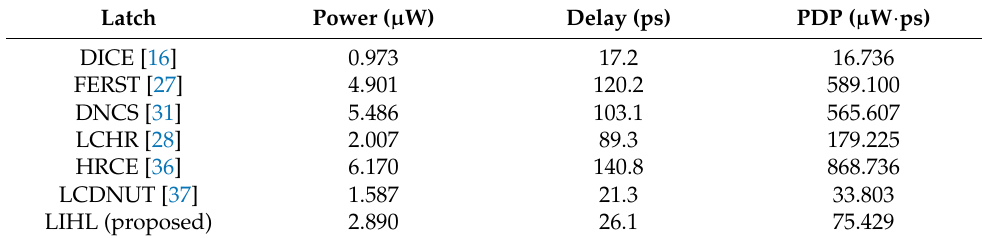
Figure 21. Power consumption of various latch designs under different V th . Table 2. Power, Delay, and PDP Comparison at 0.9 V.